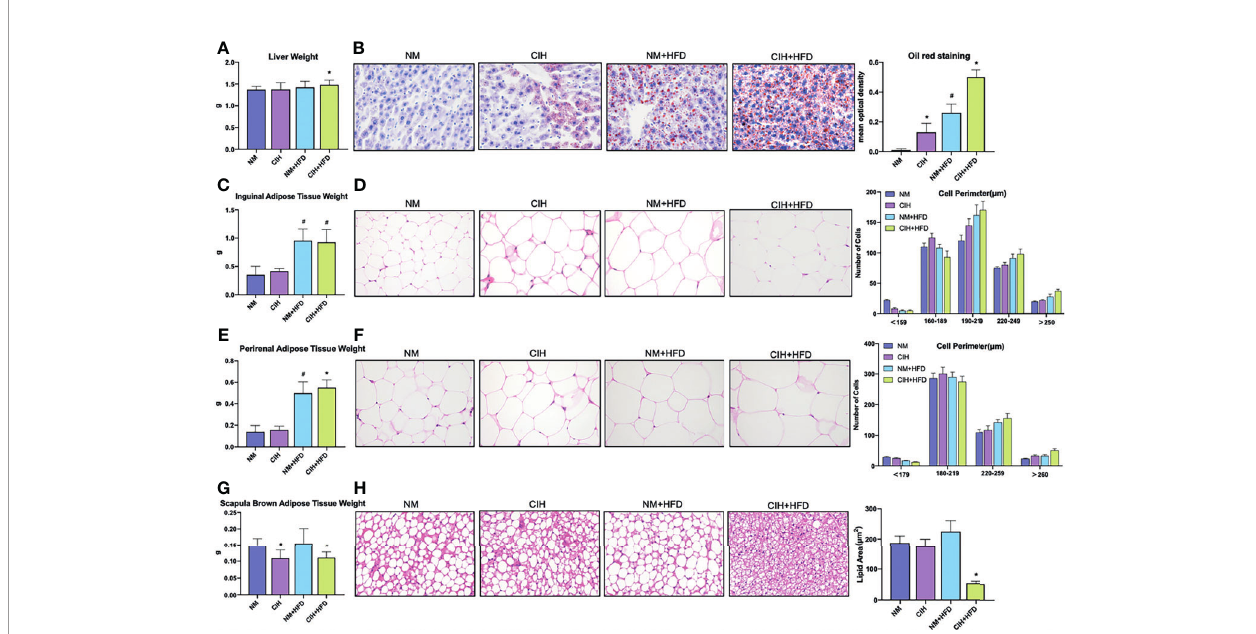
FIGURE 2 | Pro fi les of liver tissue, abdominal subcutaneous and visceral white adipose tissue, and scapula brown adipose tissue of mice exposed to CIH intervention. (A) Liver weights of the mice in the chow diet and HFD groups pre- and post- CIH. (B) Oil red staining of liver tissue and mean optical density of the mice in the chow diet and HFD groups pre- and post- CIH. (C) Inguinal adipose tissue (Abdominal subcutaneous white adipose tissue) weights of the mice in the normal and HFD groups before and after CIH. (D) Hematoxylin-eosin staining and the distribution of adipocyte perimeters of inguinal adipose tissue of the chow diet- fed and HFD-fed mice before and after CIH. (E) Perirenal adipose tissue (abdominal visceral white adipose tissue) weights of the mice in the chow diet and HFD groups pre- and post- CIH. (F) Hematoxylin-eosin staining and the distribution of adipocyte perimeters of perirenal adipose tissue of the mice and brown fat weight of the chow diet-fed and HFD-fed mice before and after CIH. (G) Scapula brown adipose tissue weights of the mice in the chow diet and HFD groups pre- and post- CIH. (H) Hematoxylin-eosin staining and lipid area of scapula brown adipose tissue of the mice in the chow diet and HFD groups pre- and post- CIH. Data are expressed as mean ± SEM. Group differences were assessed by using the Mann ‐ Whitney U test. *P < 0.05 when comparing NM and CIH groups (NM group vs CIH group, NM+HFD group vs CIH+HFD group). # P < 0.05 when comparing chow diet and HFD groups (NM group vs NM+HFD group). Original magni fi cation: 400